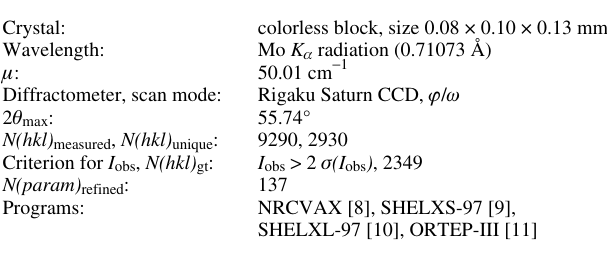
Table 1. Data collection and handling.